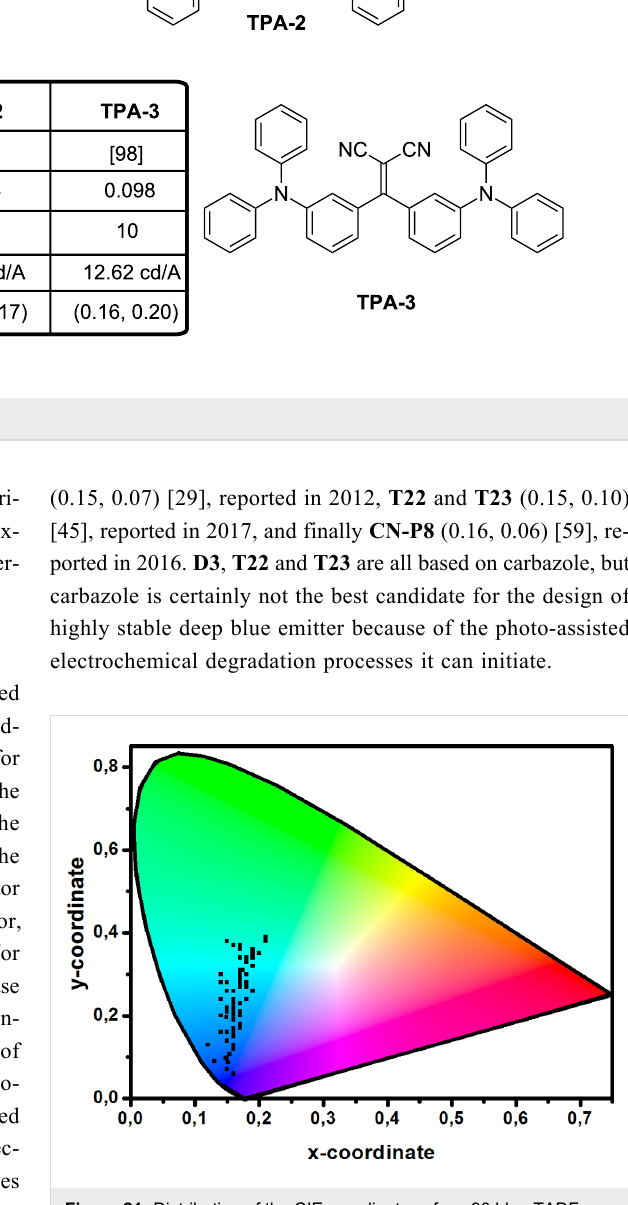
Figure 21: Distribution of the CIE coordinates of ca. 90 blue TADF emitters listed in this